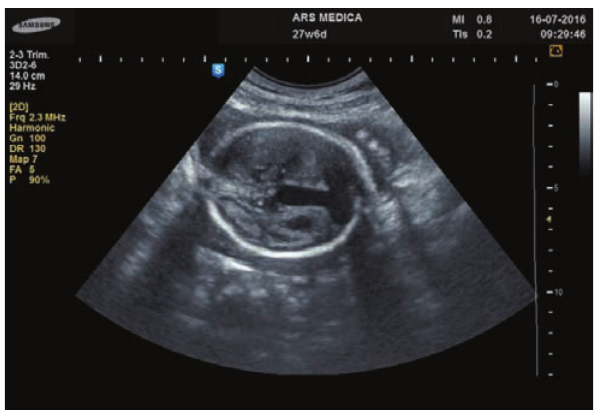
Figure 1: Fetal brain transverse view: anechoic supratentorial tubular structure, located sagitally and spreading bilaterally